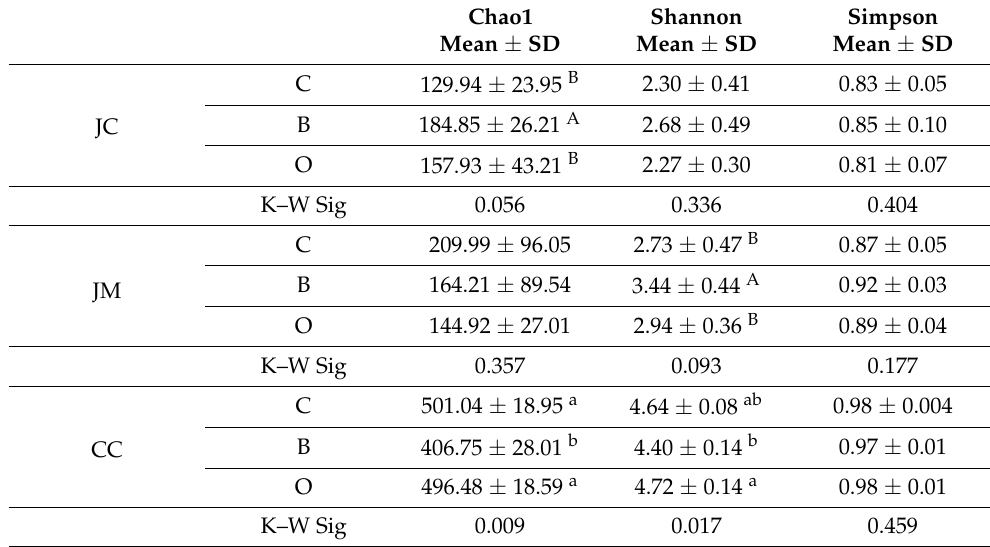
Table 5. Diversity indices of the intestinal microbiota of broiler chickens.